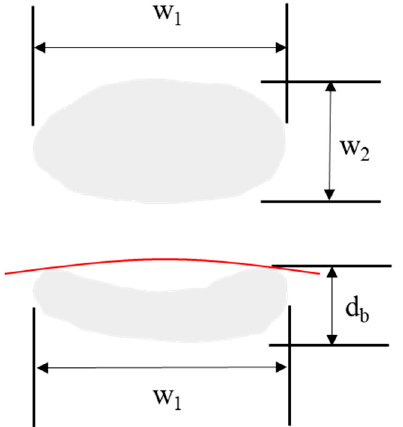
Figure 3. Elliptical bruise thickness method used for BA and BV.